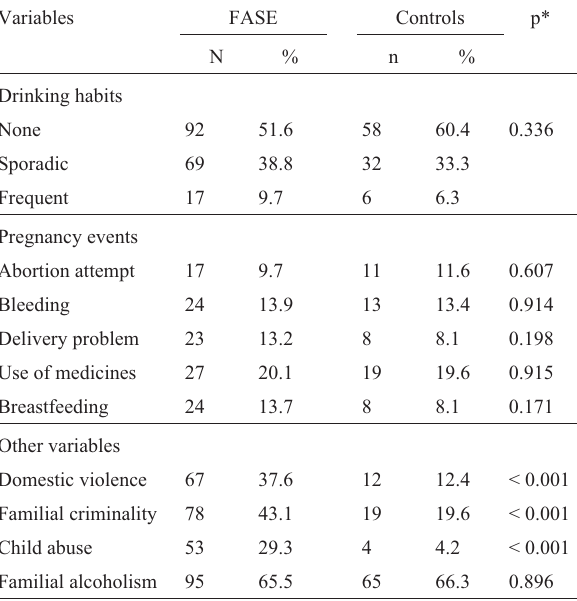
Table1 -Pregnancyqualityandfamilialhistoryinadolescentswithcrimi- nal behavior (FASE) and in the school students (controls).